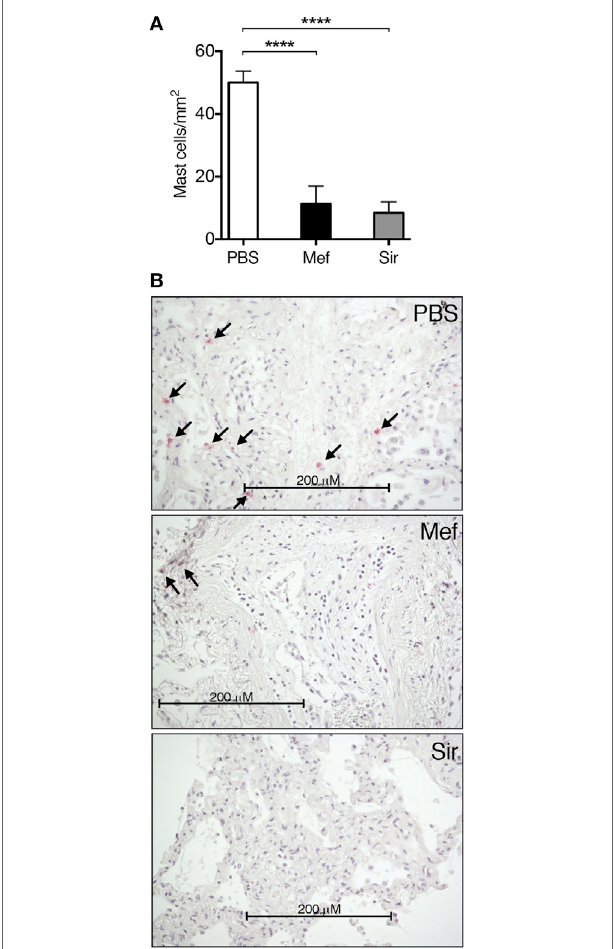
FigUre 1 | Mefloquine and siramesine reduce the number of mast cells in human lung tissues. Human lung specimens were incubated in media containing 20 µM of mefloquine, siramesine, or phosphate-buffered saline (PBS; as vehicle) for 24 h. Cross sections of the lung specimens were then prepared and immunostained for tryptase followed by nuclear counterstaining with Mayer’s hematoxylin to evaluate the number of lung mast cells. (a) Quantification of the number of lung tryptase + mast cells ( n = 5–10; representative of two independent experiments/two donors). The graphs show mean ± SEM (**** P < 0.0001). (B) Representative images of lung sections showing the reduction in the number of tryptase + mast cells (arrows) in the presence of mefloquine or